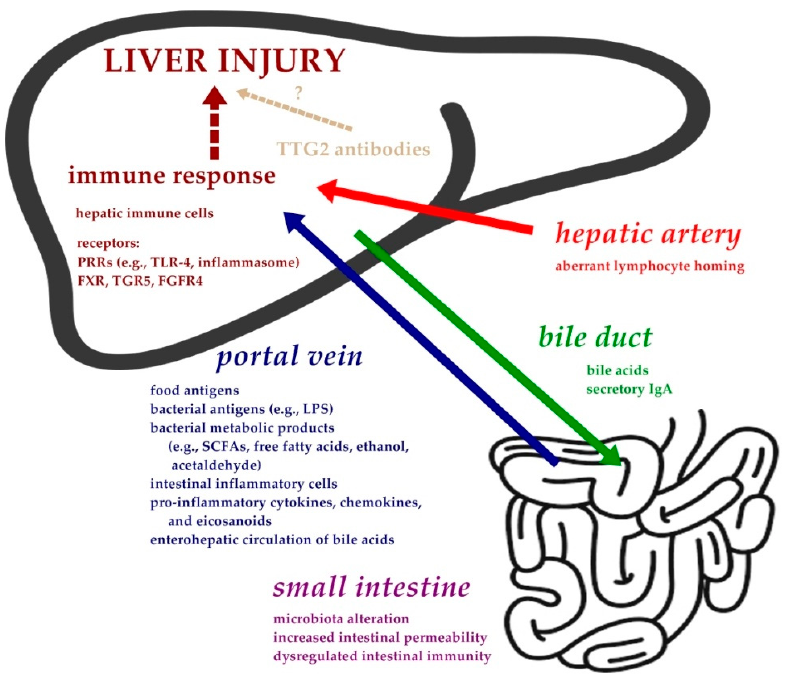
Figure 1. Putative pathogenesis of liver injury in celiac disease. Abbreviations: FGFR4, fibroblast growth factor receptor 4; FXR, farnesoid X receptor; LPS, lipopolysacharide; NLRs, NOD like receptors; PRRs, pattern-recognition receptors; SCFAs, short chain fatty acids; TGR5, Takeda G-protein receptor 5; TLR-4, toll like receptor 4; TTG2, tissue transglutaminase 2.